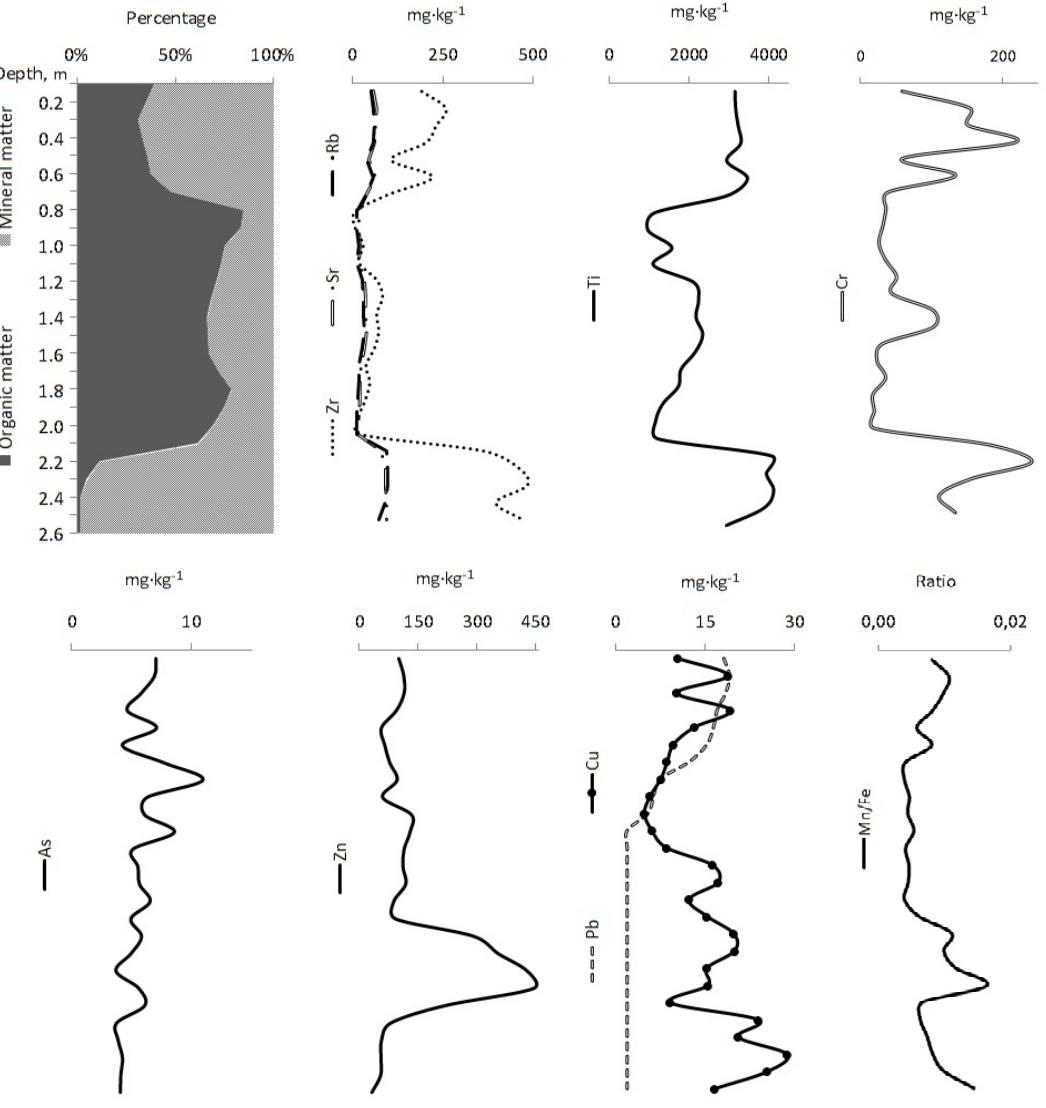
Figure 6. Main sediment components and concentrations of heavy metals in sediments of Lake Salot ė .